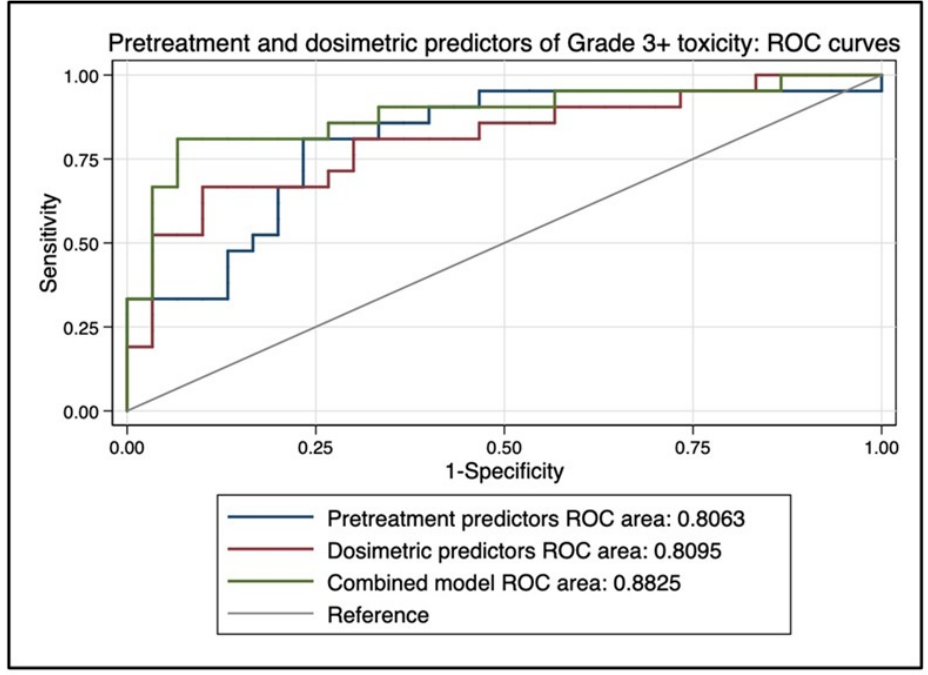
Figure 6. Area under the curve (AUC) estimate for predicting complete response on receiver oper- ating characteristic (ROC) analysis. A combined multivariate model using only baseline bilirubin level and mean dose to non-tumorous liver achieved an AUC estimate of 0.88 as a predictor of ≥ grade 3 toxicity.